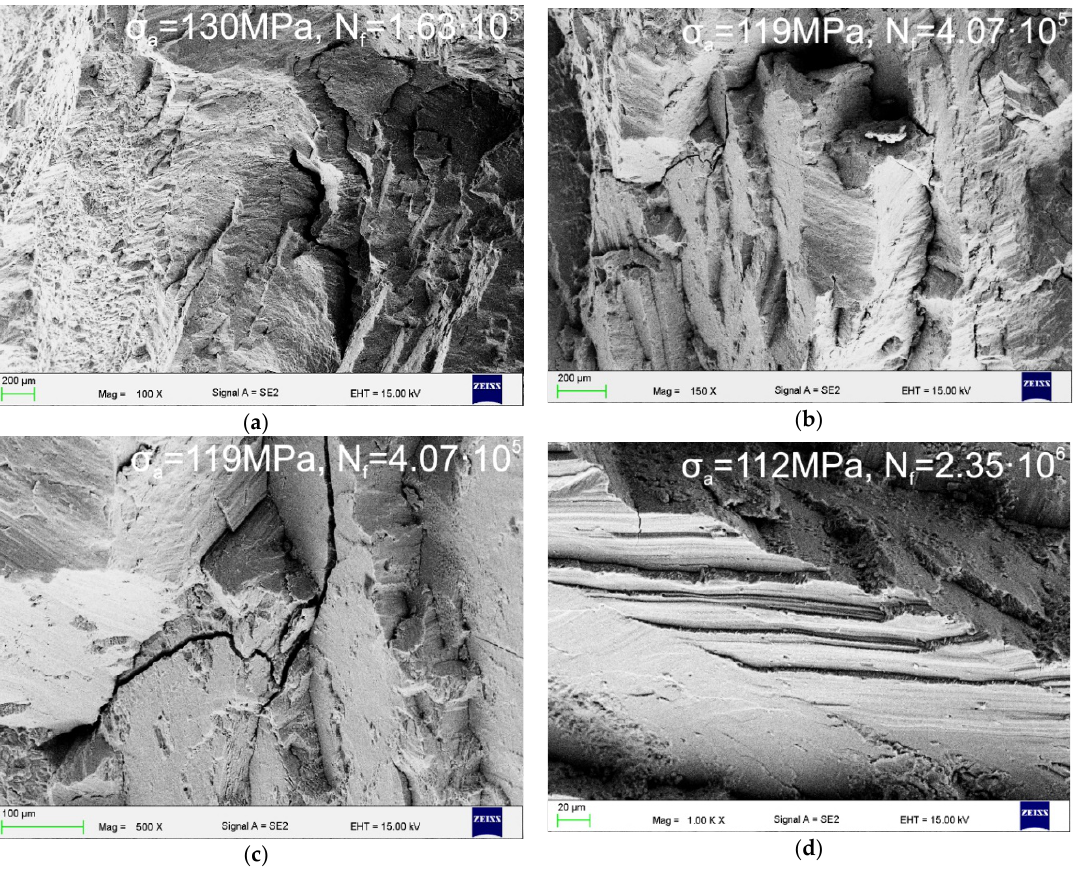
Figure 7. ( a ) Differently oriented systems of jogs of cleavage planes with various heights ; ( b ) Inhomogeneous surfaces of jogs on fatigue fracture planes ; ( c ) Systems of differently oriented cleavage planes ; ( d ) Surfaces of fatigue cracking with cascade of jogs.